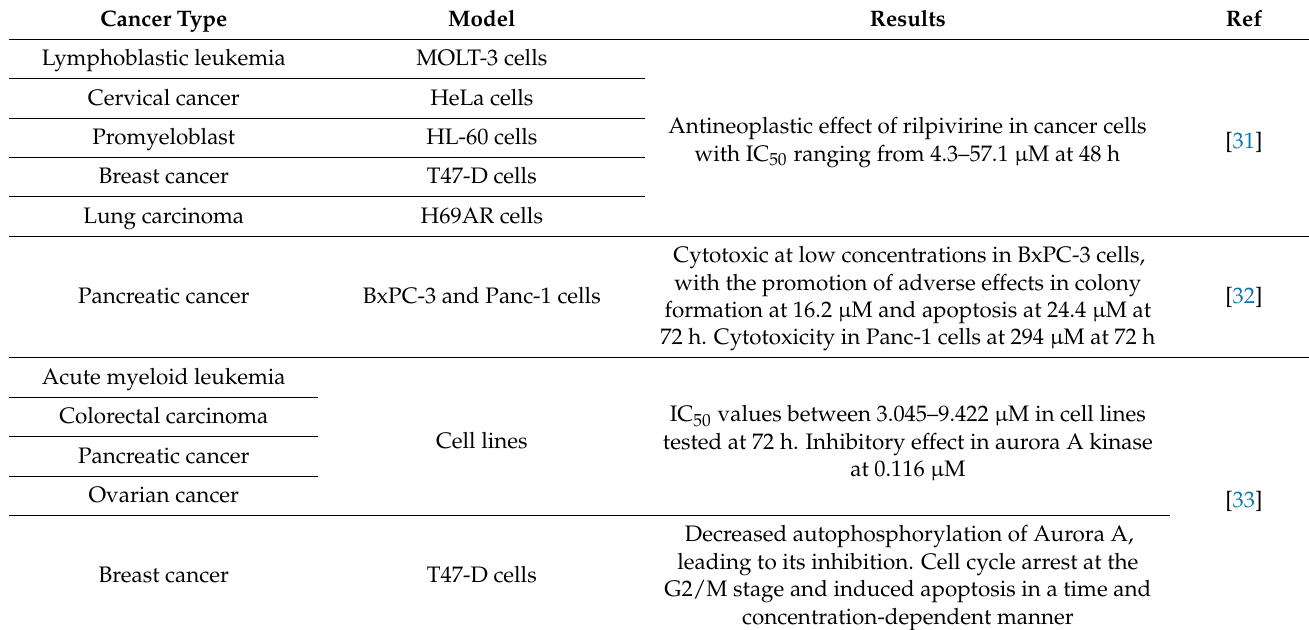
Table 1. Works related to the repurposing of Rilpivirine in